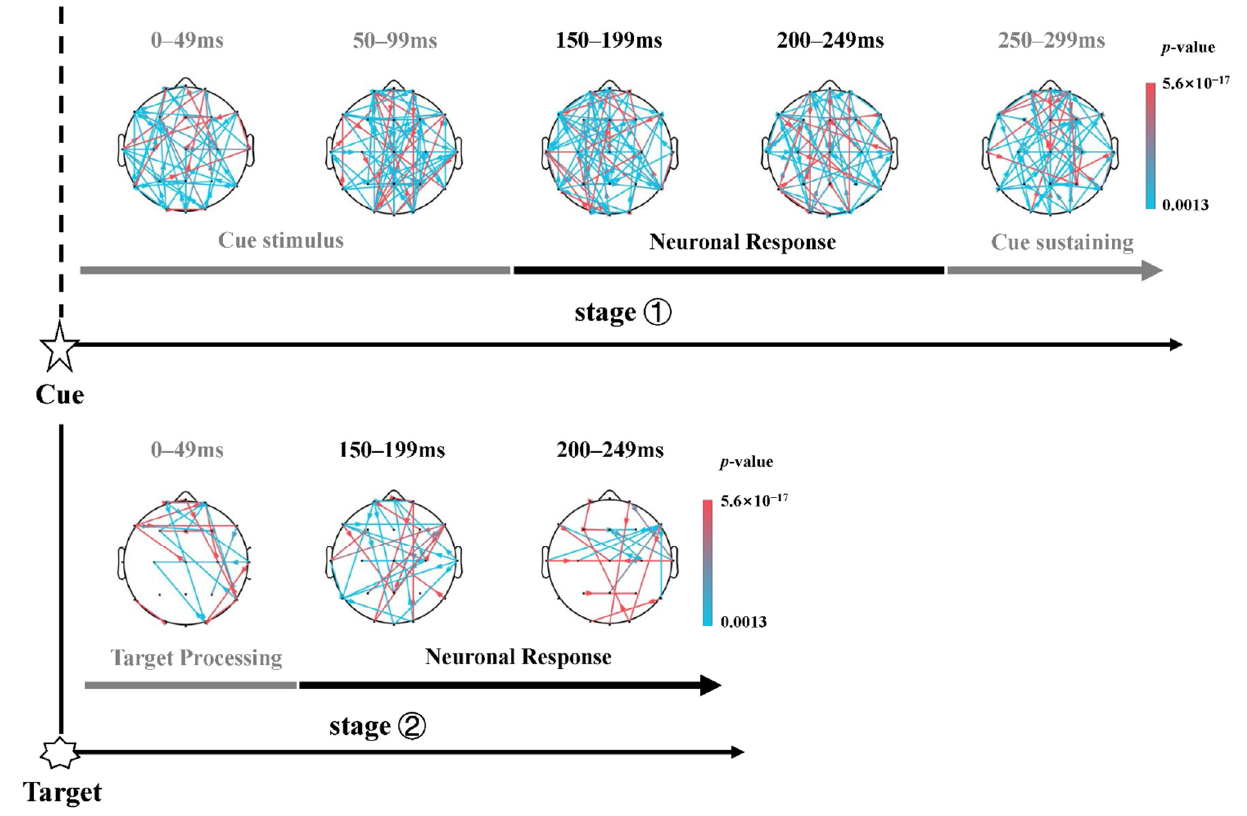
Figure 8. Dynamic information flow corresponding to the orienting network in six distinct sub- stages during two stages within frequency band of 1–30 Hz. Stronger information flow induced by spatial cue compared to center cue. Upper panel: dynamical brain network after the onset of cue ( t (38) = 2.998, p < 0.005, FDR corrected). Lower panel: dynamical brain network after the onset of target ( t (38) = 8.617, p < 0.005, FDR corrected).